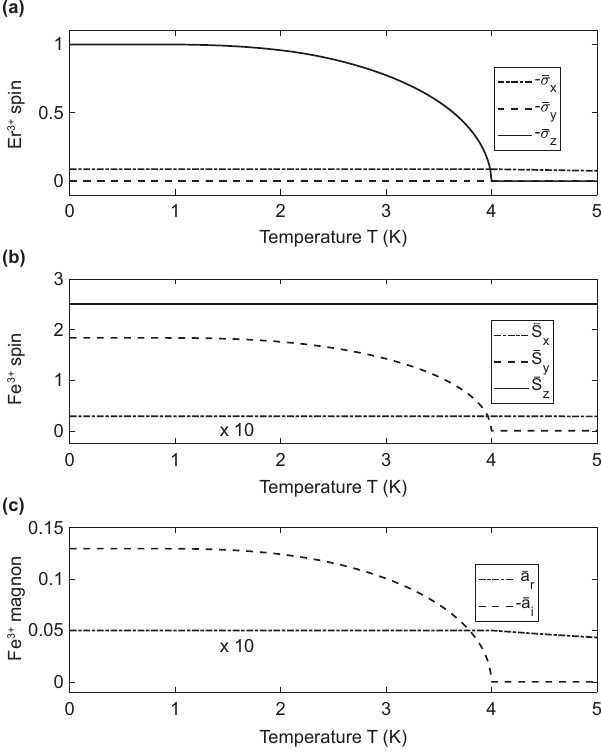
Fig. 4 Thermal equilibrium spin and amplitude values. a Er 3 þ spins. b Fe 3 þ spins. c Fe 3 þ magnon amplitudes as functions of T . These values were calculated using the semiclassical method with the extended Dicke Hamiltonian in the case of zero external direct current (DC) magnetic fi eld. Figure 4a, b are nearly the same as Fig. 3a, b, respectively, except (cid:2) S z , which changes only slightly due to magnon bosonization. The Fe 3 þ spins, (cid:2) S x ; y ; z , were calculated using Eqs. (113) – (115) with the thermal equilibrium value of the quasi-antiferromagnetic (qAFM) magnon annihilation operator h ^ a π i ¼ ffiffiffiffi p N ð (cid:2) a r þ i (cid:2) a i Þ plotted in Fig.